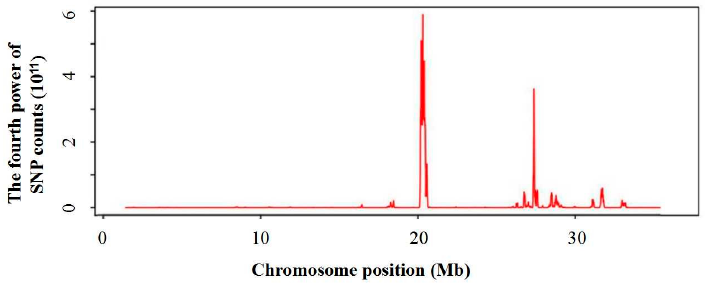
Figure 6. Distribution of SNP loci on chromosome 3. Peak at the position of 20,546–21,231 Kb on the chromosome 3 of indica cultivar